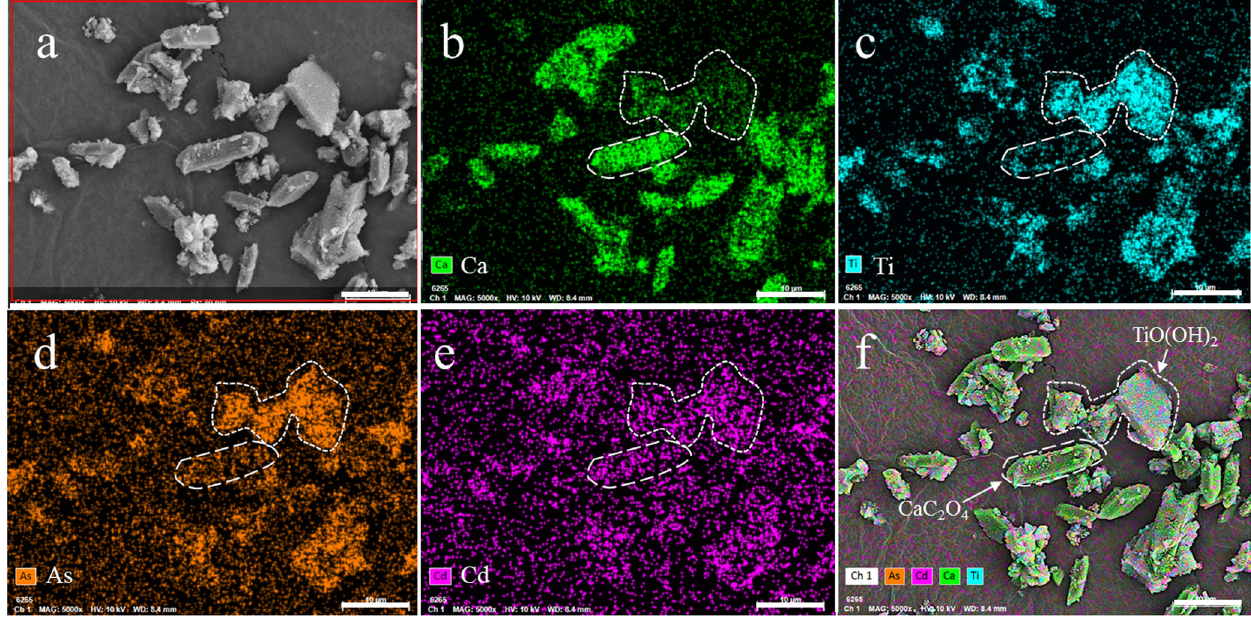
Fig. 6 Scanning electron microscope (SEM) image and elemental distribution of the fl oc precipitate. ( a ) SEM image, ( b ) Ca, ( c ) Ti, ( d ) As, ( e ) Cd, and ( f ) overlay of SEM and elemental distribution images. Scale bar is 10 μ